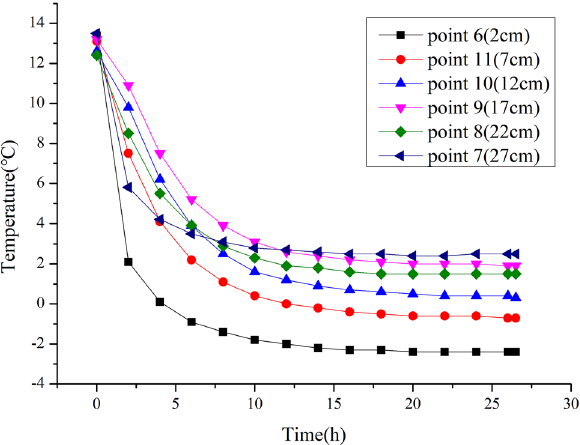
Figure 8. Temperature variation curve for different temperature measurement points inside sample (Note: the temperature does not change after the 18th hour).